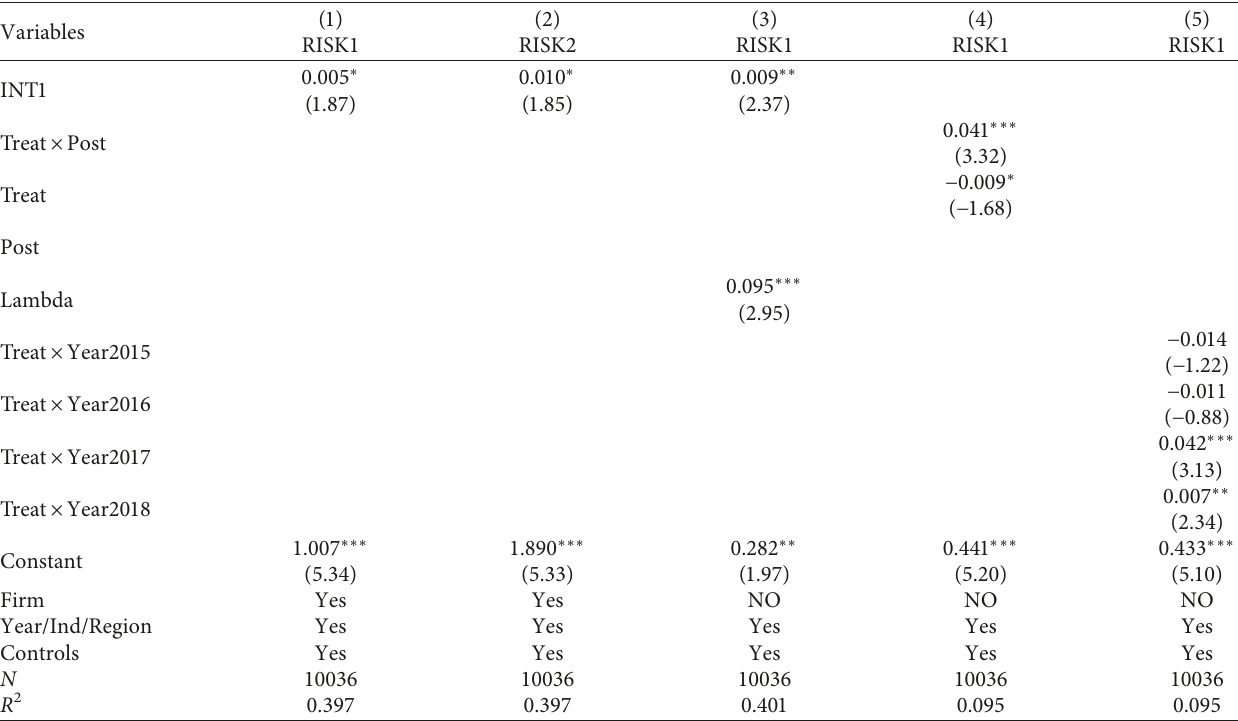
Table 5: Endogeneity